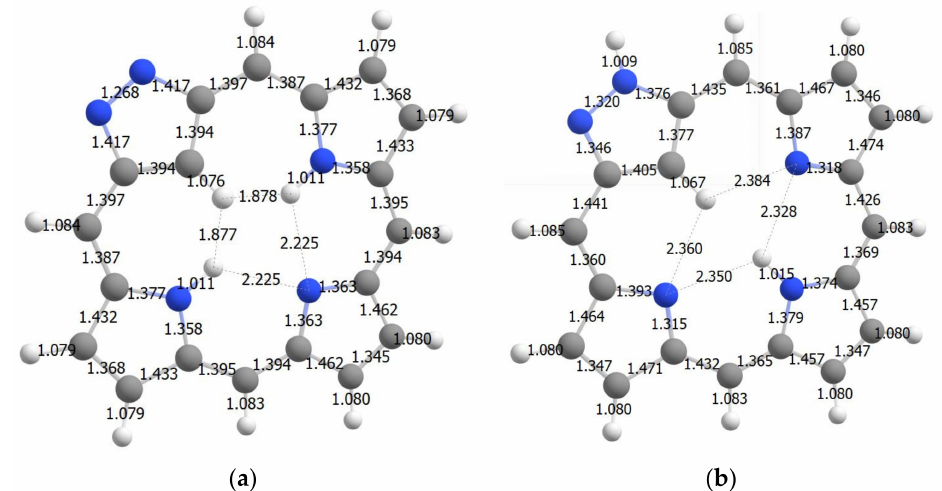
Figure 4. AICD plots (isovalues 0.05) for PzP-22,24-H ( a ) and PzP-21,23-H ( b ).